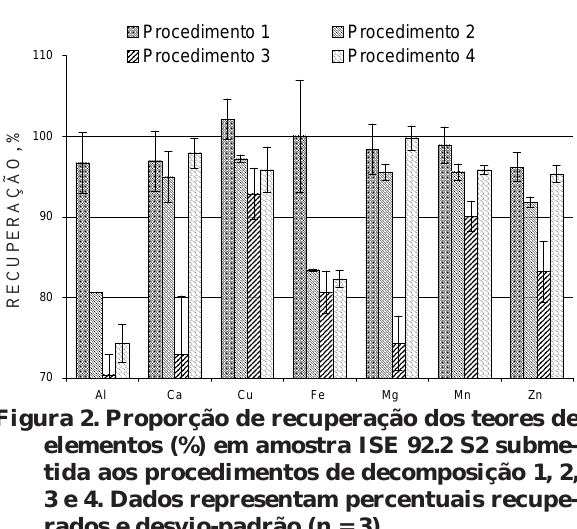
Figura 1. Proporção de recuperação dos teores de elementos (%) em amostra NIST 2709 submeti- da aos procedimentos de decomposição 1, 2, 3 e 4. Dados representam percentual recuperado e desvio-padrão (n = 3).